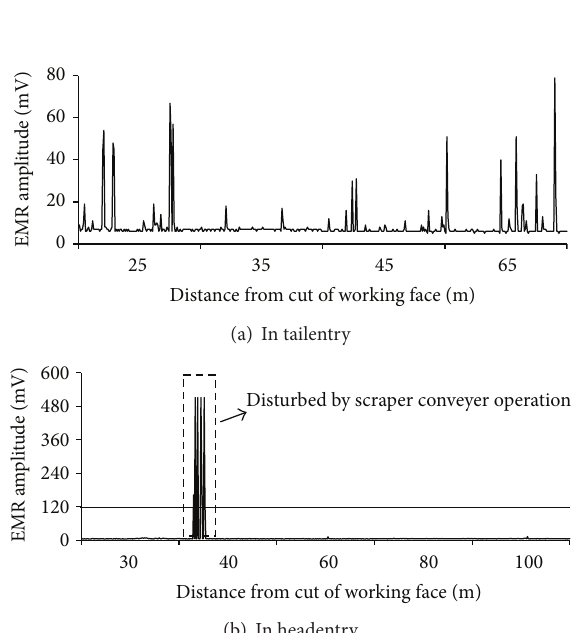
Figure 10: The layout diagram of 7303 working face.